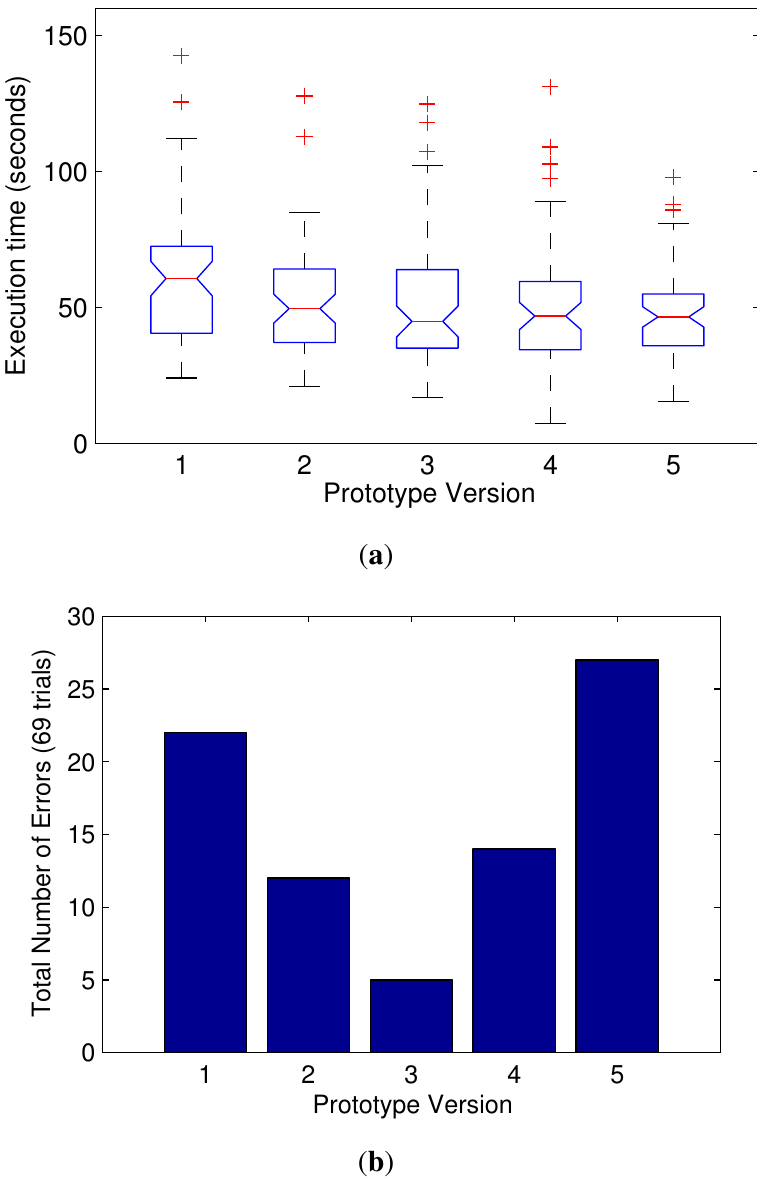
Figure 9. Plots of the different prototypes’ performance in terms of task completion times and number of errors (failure to identify the inclusion count). The central mark is the median, and the edges of the box are the 25th and 75th percentiles. ( a ) Task completion times for the different prototypes; ( b ) total number of errors for each